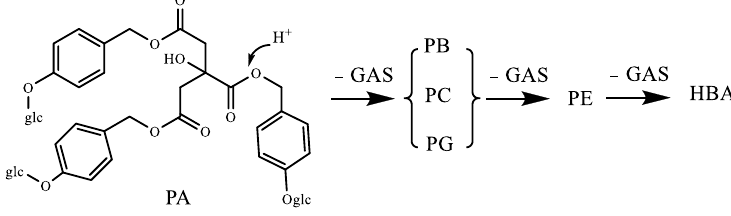
Figure 5. The hydrolysis pathways of parishin A.